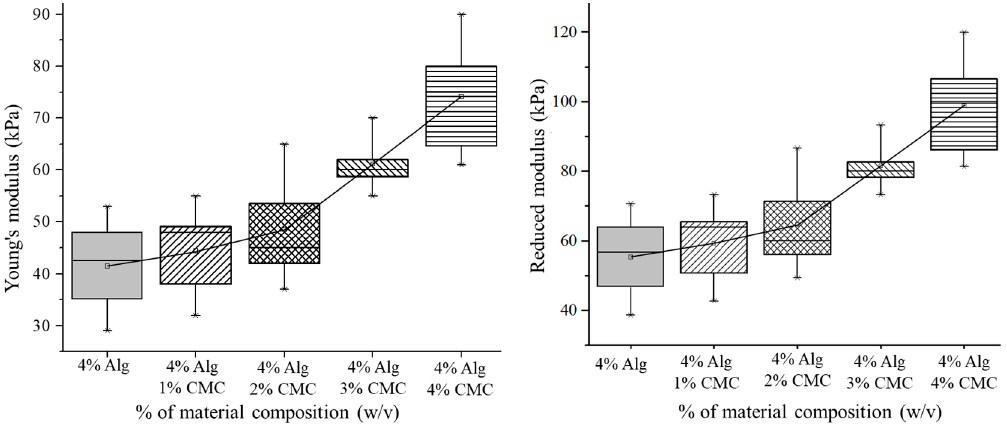
Figure 9. Young’s and Reduced Modulus.